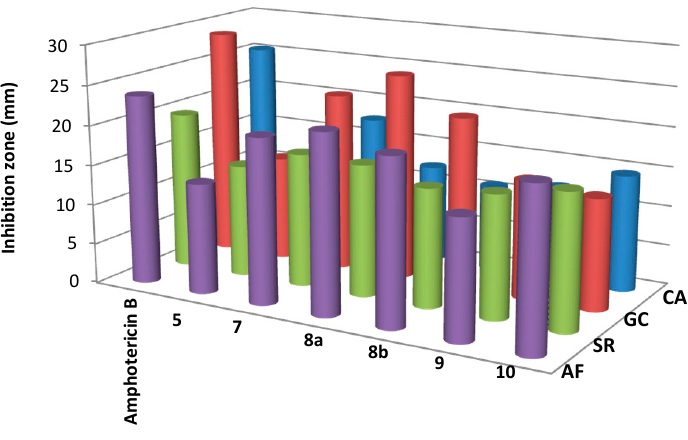
Figure 4. Antifungal activity of the synthesized thiophene derivatives.